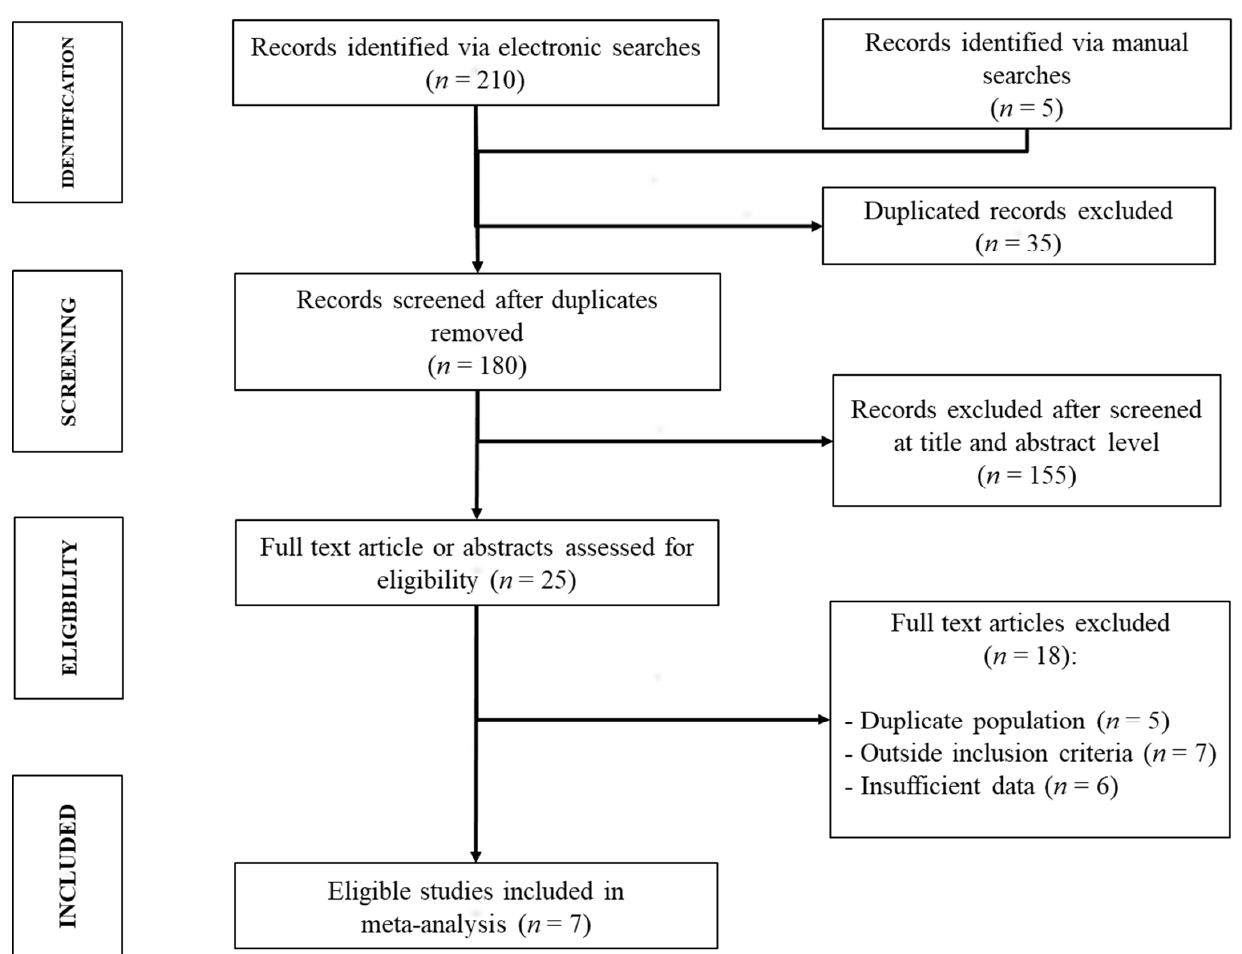
Figure 1. The Preferred Reporting Items for Systematic Reviews and Meta-Analyses (PRISMA in Supplementary Material 1) flow diagram of the systematic literature search and the studies included in the meta-analysis.